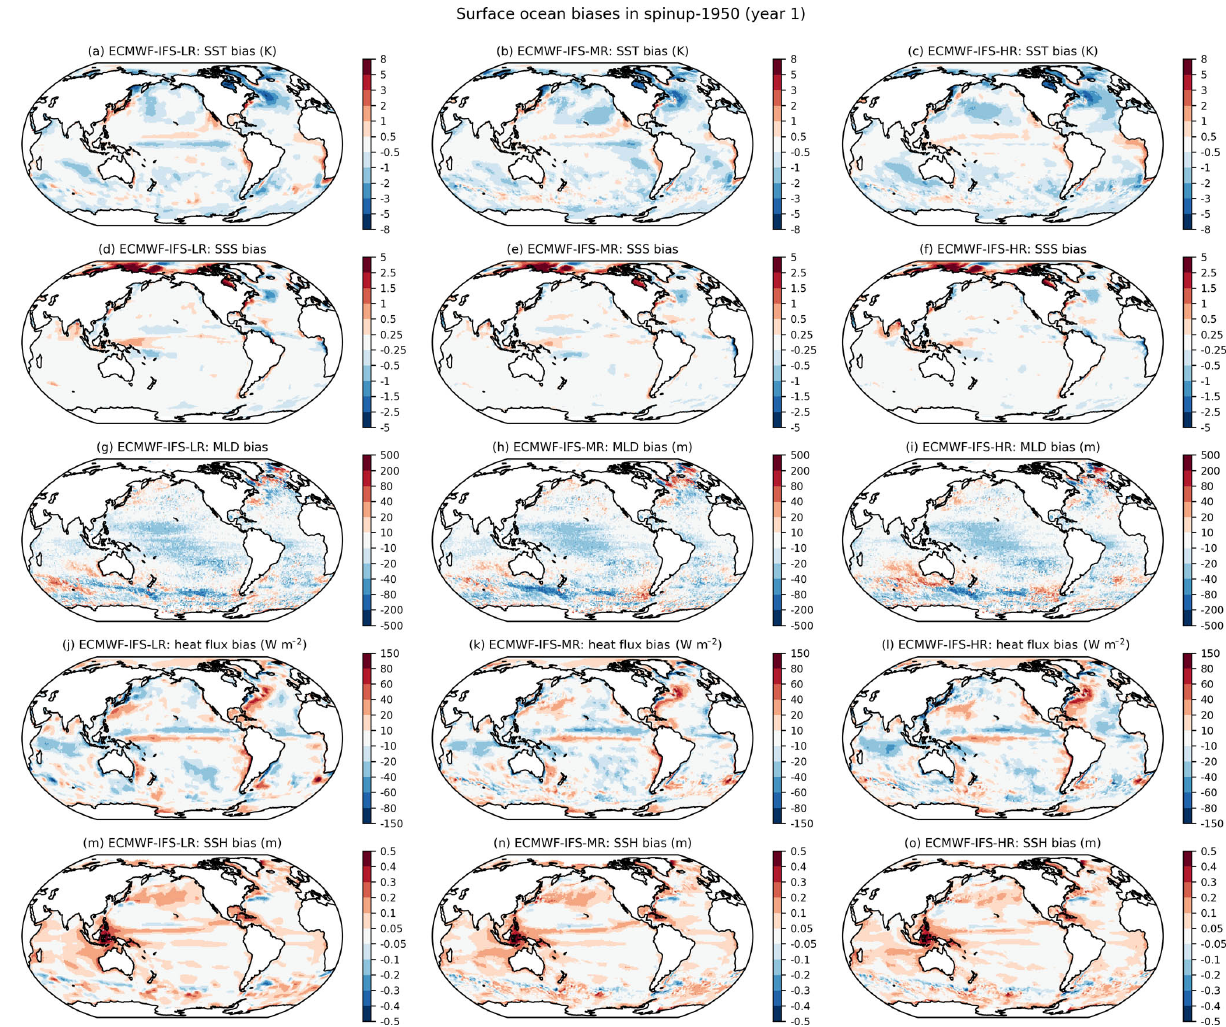
Figure 13. As Fig. 3 but calculated for the first year of